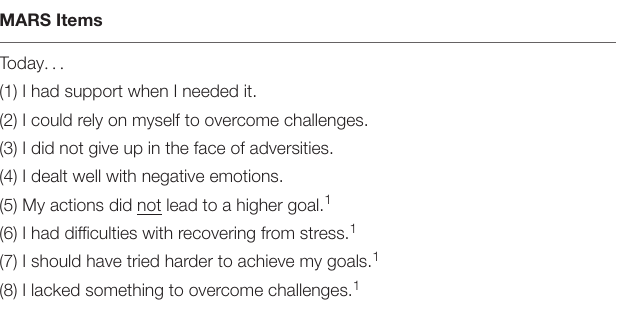
TABLE 1 | Items related to Monitoring of Actual Resilience State (MARS). MARS Items Today